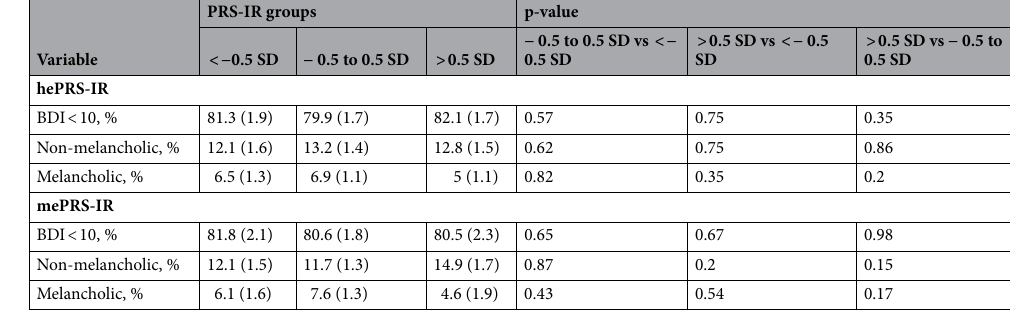
Table 4. The biologically informed hippocampal (hePRS-IR) and mesocorticolimbic (mePRS-IR) polygenic risk score for insulin receptor according to depressive type. Data are shown as predicted mean probability (standard error) . Model adjusted for age, sex and population stratification, smoking, alcohol usage, socioeconomic class, body mass index, leisure-time physical activity and comorbidities. BDI Beck Depression Inventory, hePRS-IR hippocampal biologically informed polygenic risk score for insulin resistance, mePRS-IR mesocorticolimbic biologically informed polygenic risk score for insulin resistance, SD standard deviation. P values were based on the bootstrap style method of 1500 repetitions.